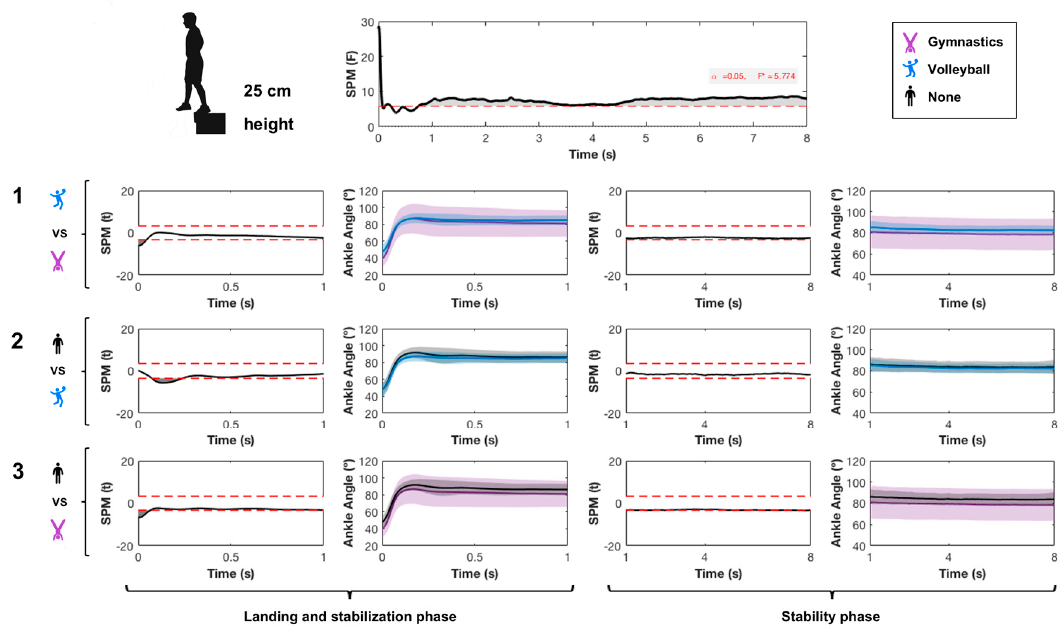
Figure 3. Effect of sports practice on ankle angle in the sagittal plane. SPM refers to statistical parametric mapping. Data acquired during landing and stability phases of single-leg landing from 25 cm height for 8 s are shown and compared. 1 refers to the pairwise comparison between gymnastics and volleyball groups; 2 refers to the pairwise comparison between volleyball and control groups; 3 refers to the pairwise comparison between gymnastics and control groups. An angle higher than 90° indicates plantarflexion while an angle lower than 90° indicates dorsiflexion.